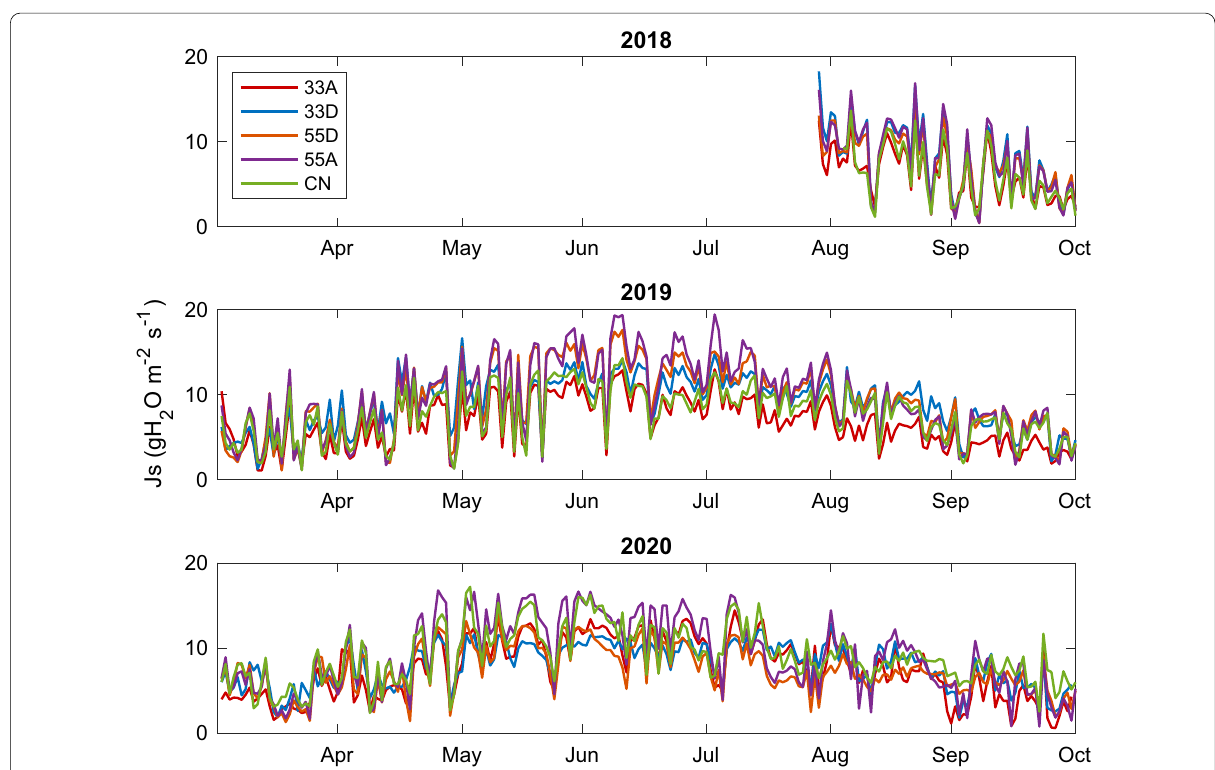
Fig. 3 Daily average sap flux density for all plot types for the growing season (1 April to 31 October) for all